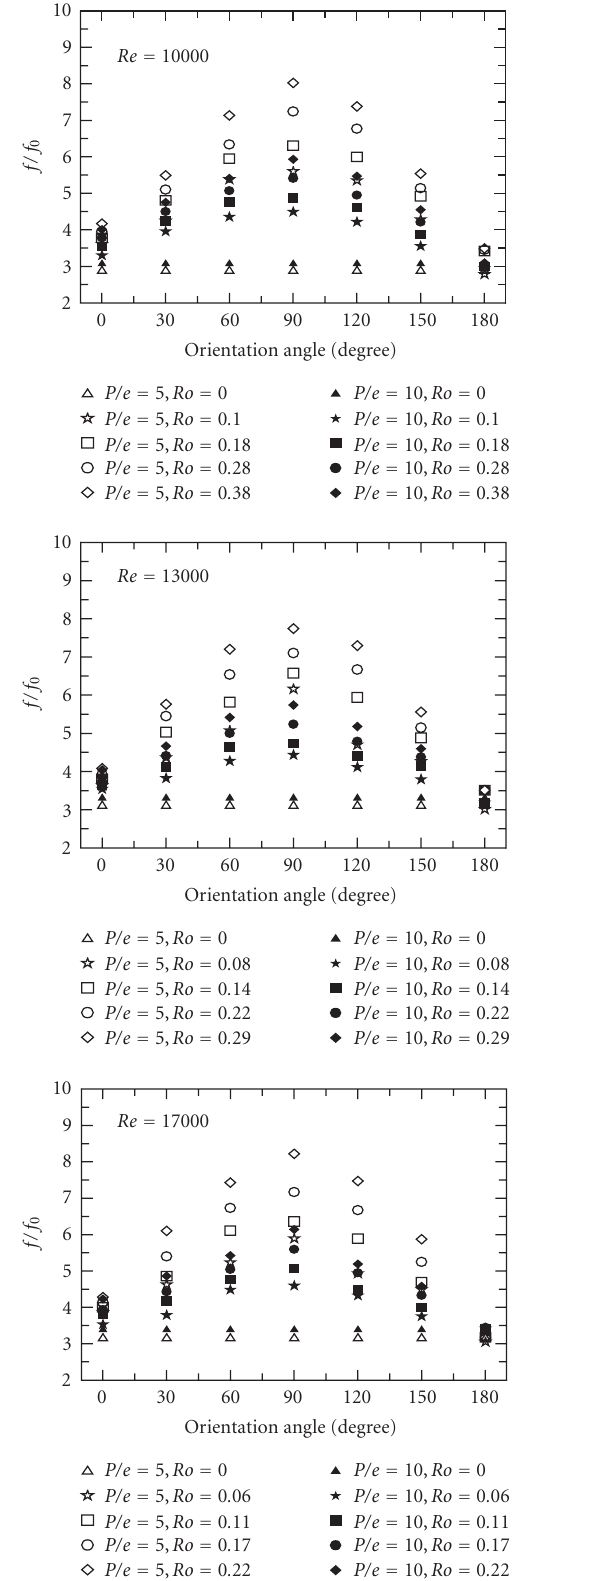
Figure 7: E ff ect of orientation angle in a rib-roughened rectangular channel with detached ribs on one wall.